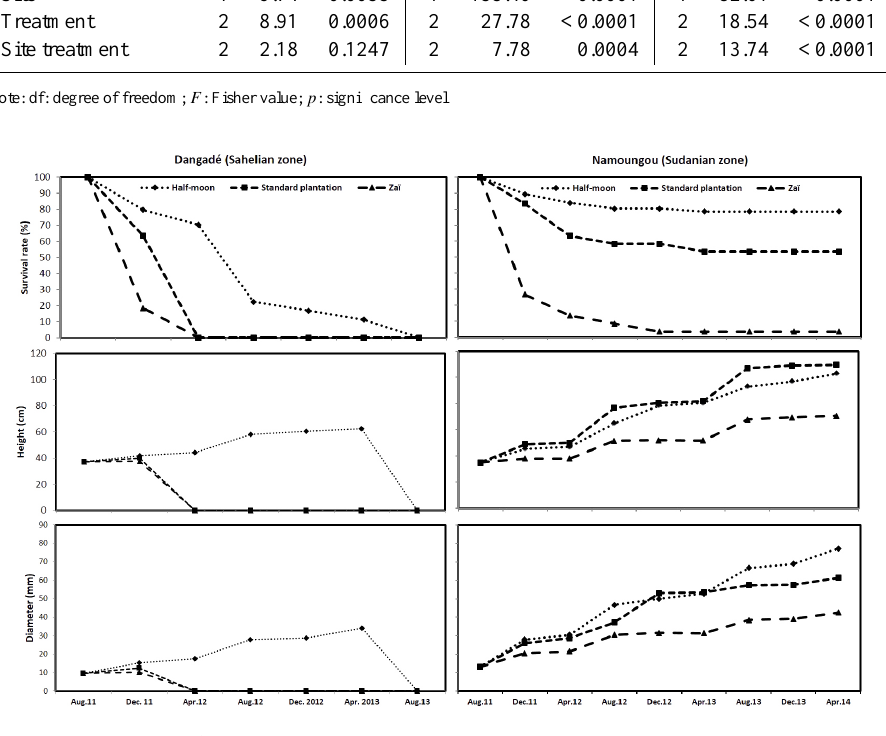
Figure 5. Survival rate and mean growth of